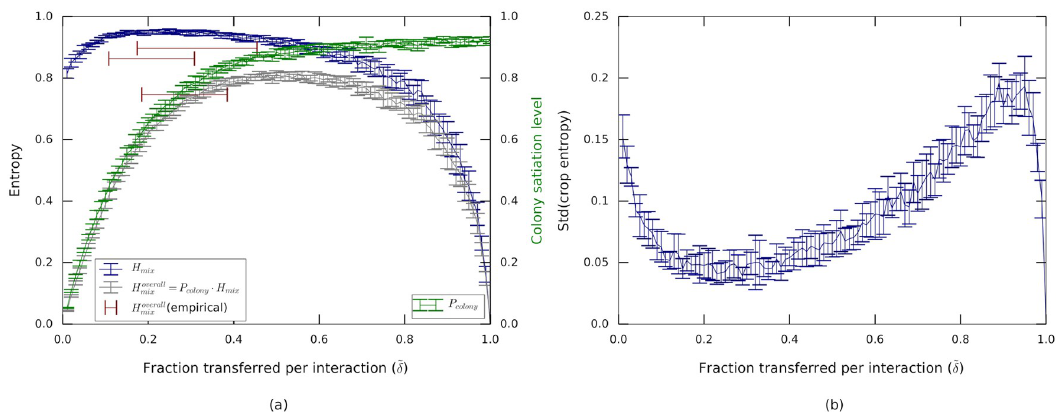
Fig 5. Trade-off between fast dissemination and efficient mixing described by the ~ d model. (a) While the colony state ( P colony , green) rises with the fraction ~ d of transferred volume, mixing levels among non-foragers (which we call H mix ) decrease. The mixing levels over all ants in the colony (including the foragers) is the product of these two functions, H overall broad maximum which spans all non-extreme values of ~ d . Curves can be compared to the empirically measured values (red bars) of the three experiments. (b) Standard deviation of individual mixing entropies h a for 30 model runs. The plot depicts the mean and standard deviation of this value.